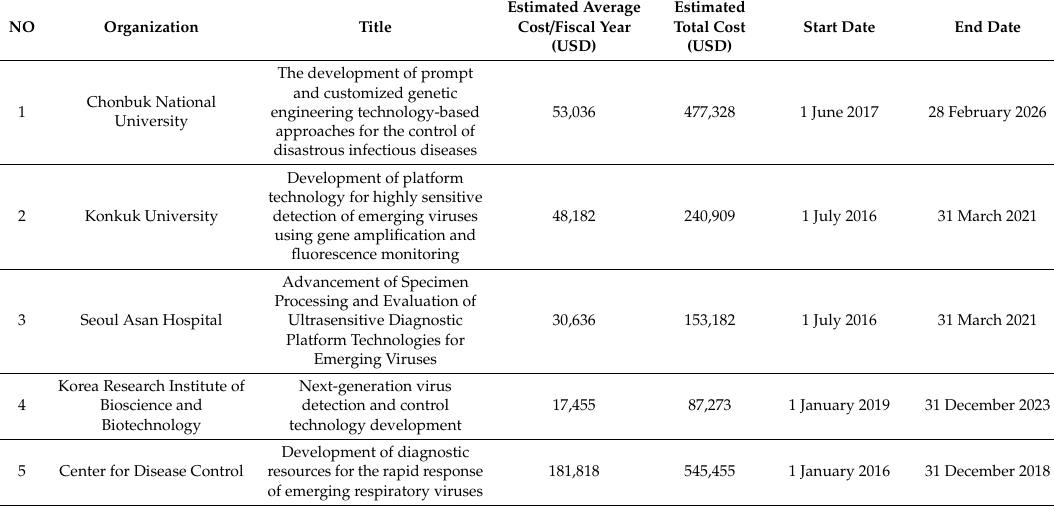
Table 10. The platform for detection and point-of-care diagnostics in Korea (Sub-Cluster